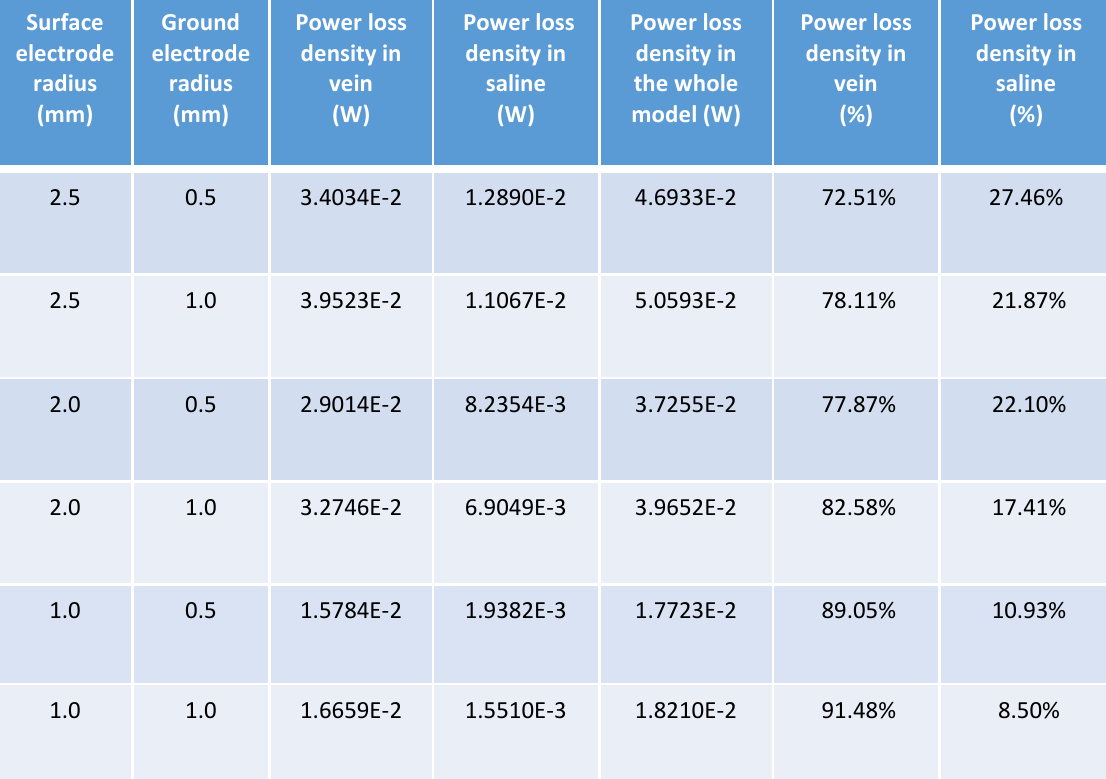
Table.9: Volumetric power loss density measurement at 1MHz with all the 32 surface electrodes excited simultaneously as terminals (8 electrodes in 4 rows)